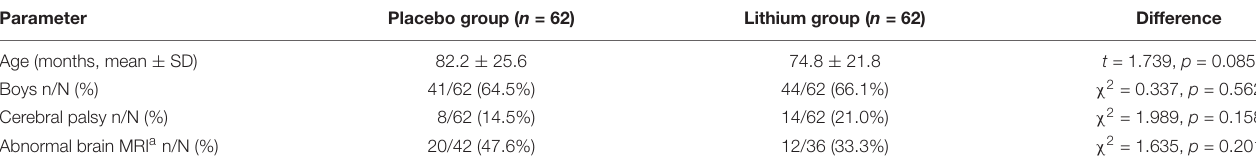
TABLE 1 | Demographic